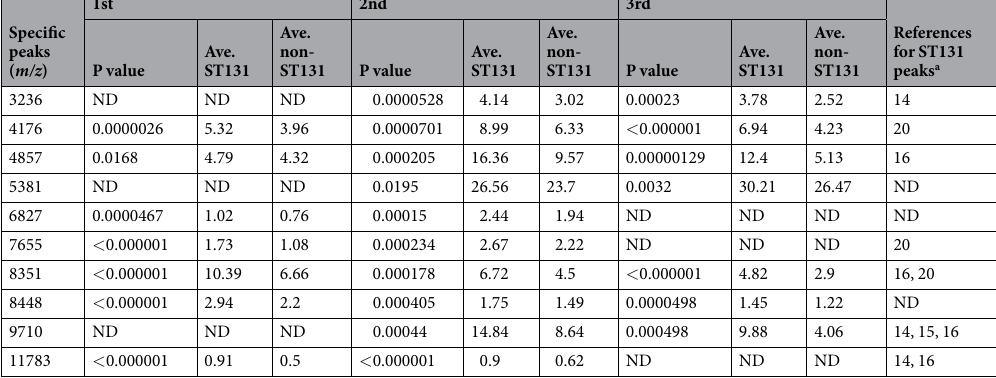
Table 1. Results of statistical analysis of the peaks of ST131 and non-ST131 using Wilcoxon rank sum test of ClinProTools. ND, not detected; Ave., peak area/intensity average. a Relevant published references for ST131- specific